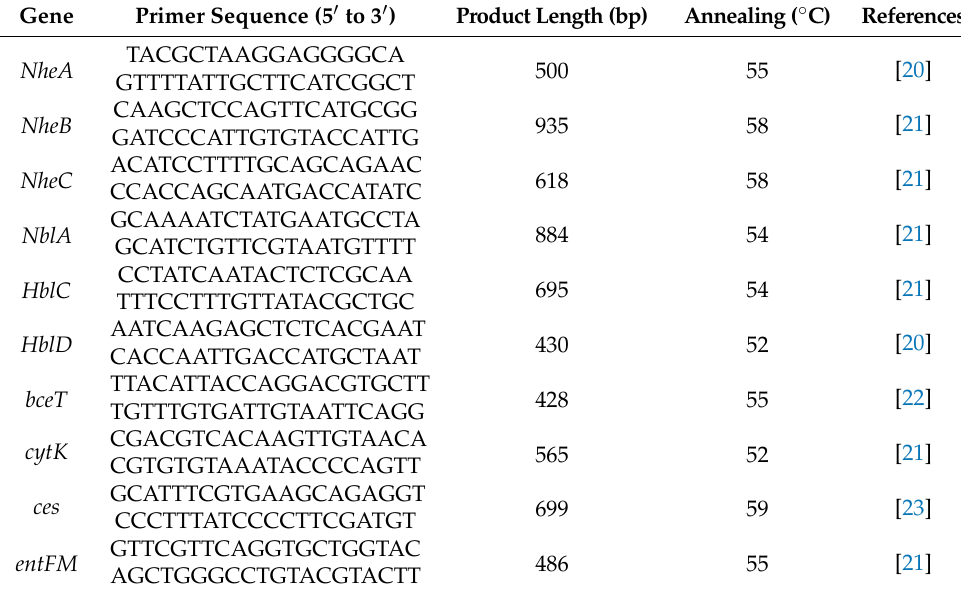
Table 1. The primers used to amplify virulence factor